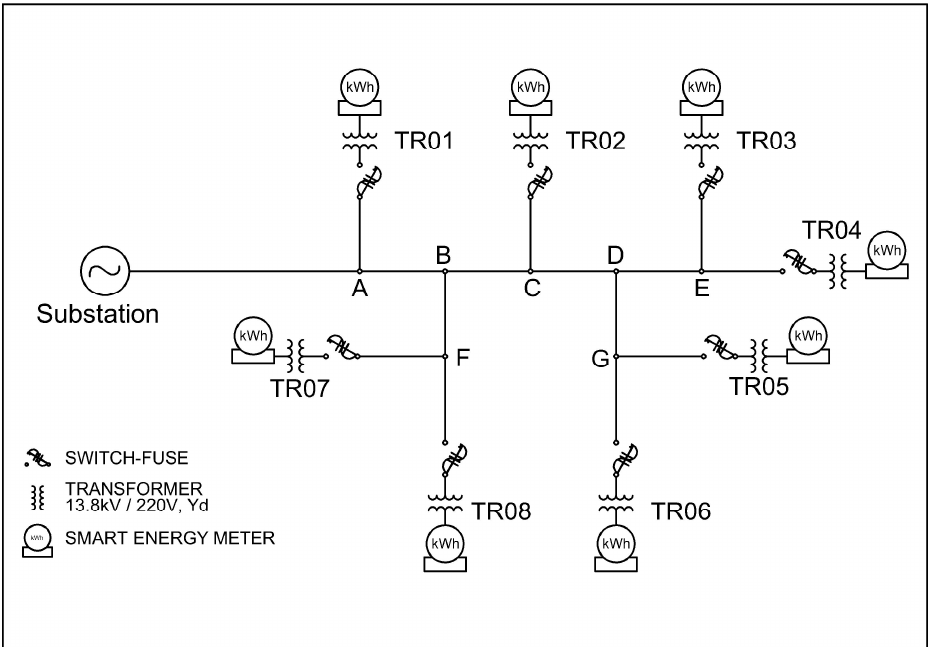
Figure 5. One-line diagram of the test distribution feeder (adapted from [28]).